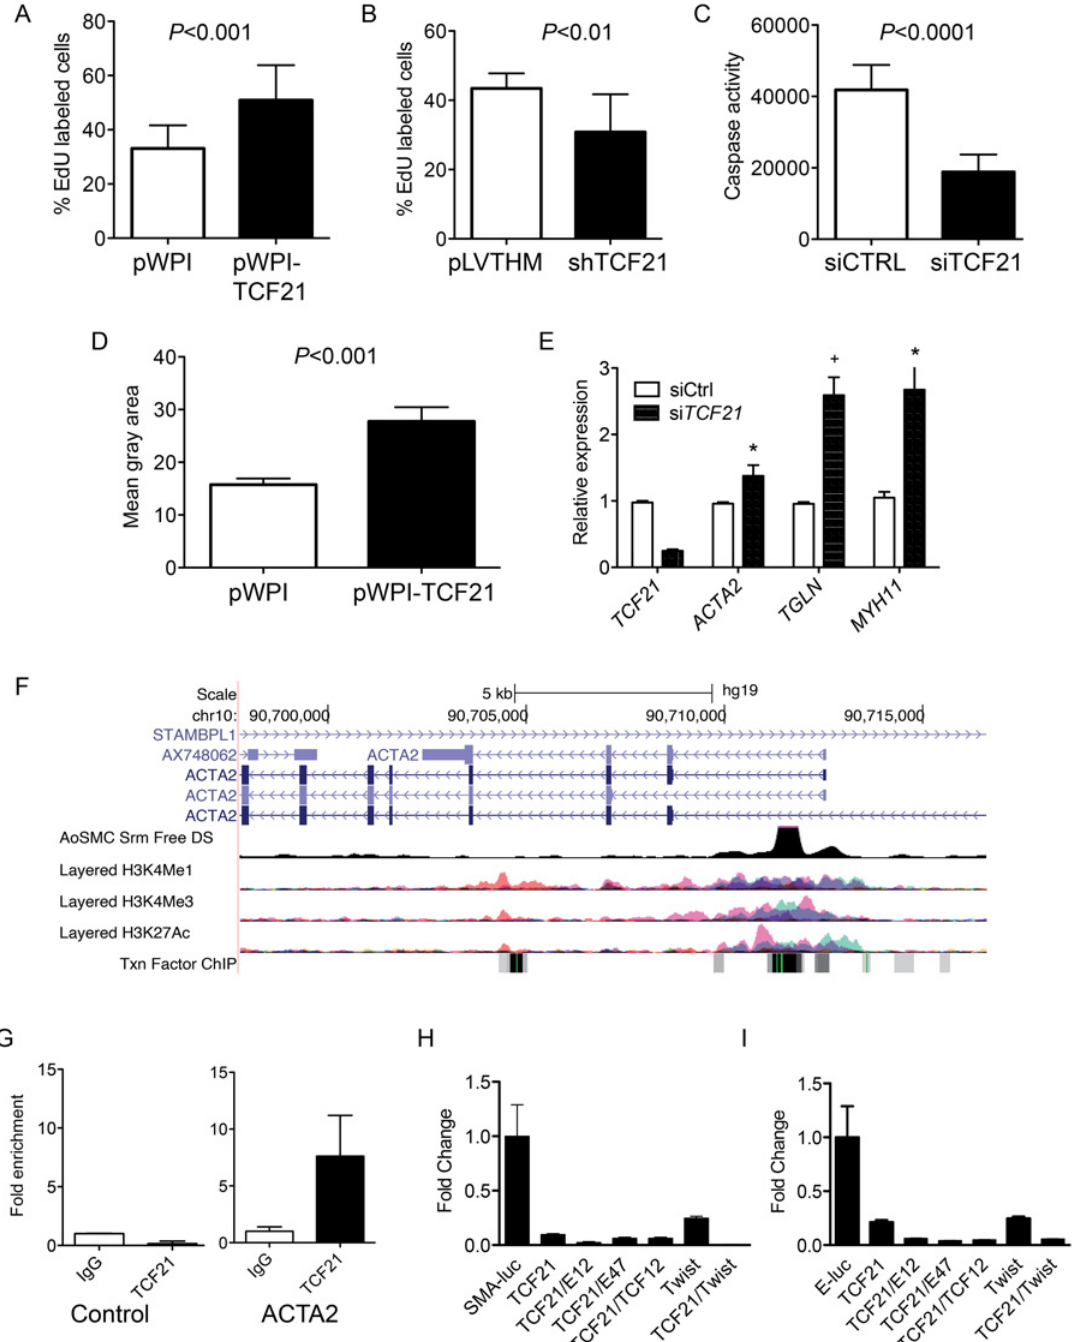
Fig 2. TCF21 regulates basic cellular functions in vascular smooth muscle cells in vitro . A) HCASMC transduced with TCF21 overexpressing lentivirus (pWPI- TCF21 ) or empty lentivirus (pWPI empty) were labeled with the thymidine analogue 5-ethynyl-2 0 -deoxyuridine (EdU), which was visualized with a fluorescent azide, allowing identification and quantification of proliferating cells with immunofluorescence microscopy, reported here as a percent with baseline being all DAPI positive cells. HCASMC showed an increase in the percentage of TCF21 overexpressing cells compared to DAPI stained cells (33.1% ± 2.3 control vs. 51% ± 4.1 overexpressing cells, P < 0.001). B) HCASMC transduced with knockdown lentiviruses showed a decreased percentage of dividing cells (43.4% ± 4.4 control vs. 30.8% ± 2.4 knockdown cells, P < 0.01). C) s iTCF21 produced a decrease in apoptosis in HCASMC as measured by a caspase activity assay (41,824 ± 1872 vs. 18,837 ± 1302, P < 0.0001). D) TCF21 regulation of HCASMC migration was evaluated with a gap closure assay. TCF21 overexpressing cells transduced with pWPI- TCF21 lentivirus covered a significantly larger surface area after 12 hours of study compared to cells transduced with the empty pWPI vector (27.8 ± 2.7 vs. 15.8 ± 1.16, P < 0.001). E) HCASMC treated with si TCF21 compared to siCTRL showed